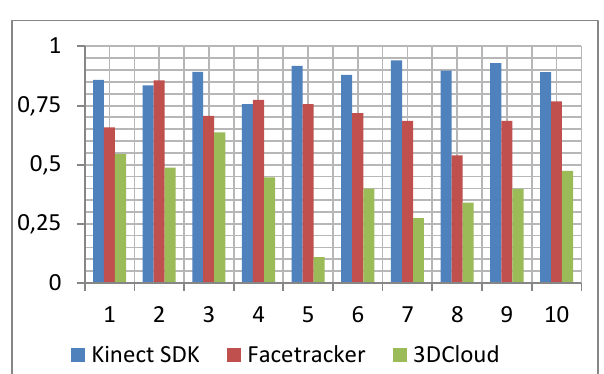
Figure 22. Mean correlation for the yaw for each candidate.